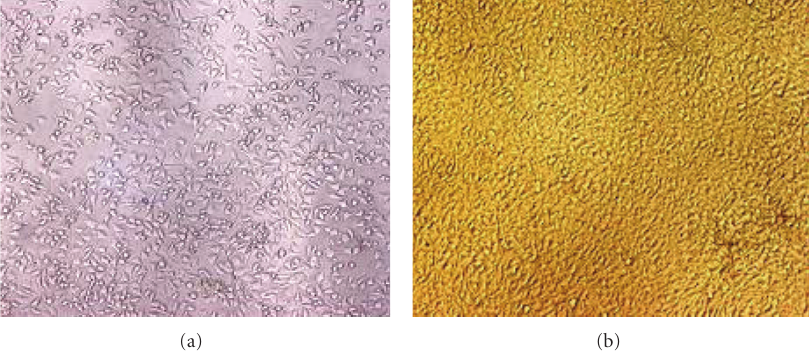
Figure 4: Fibroblast cells growth on the control sample (TCPS) (100 × ): (a) After 24 hours; (b) After 48